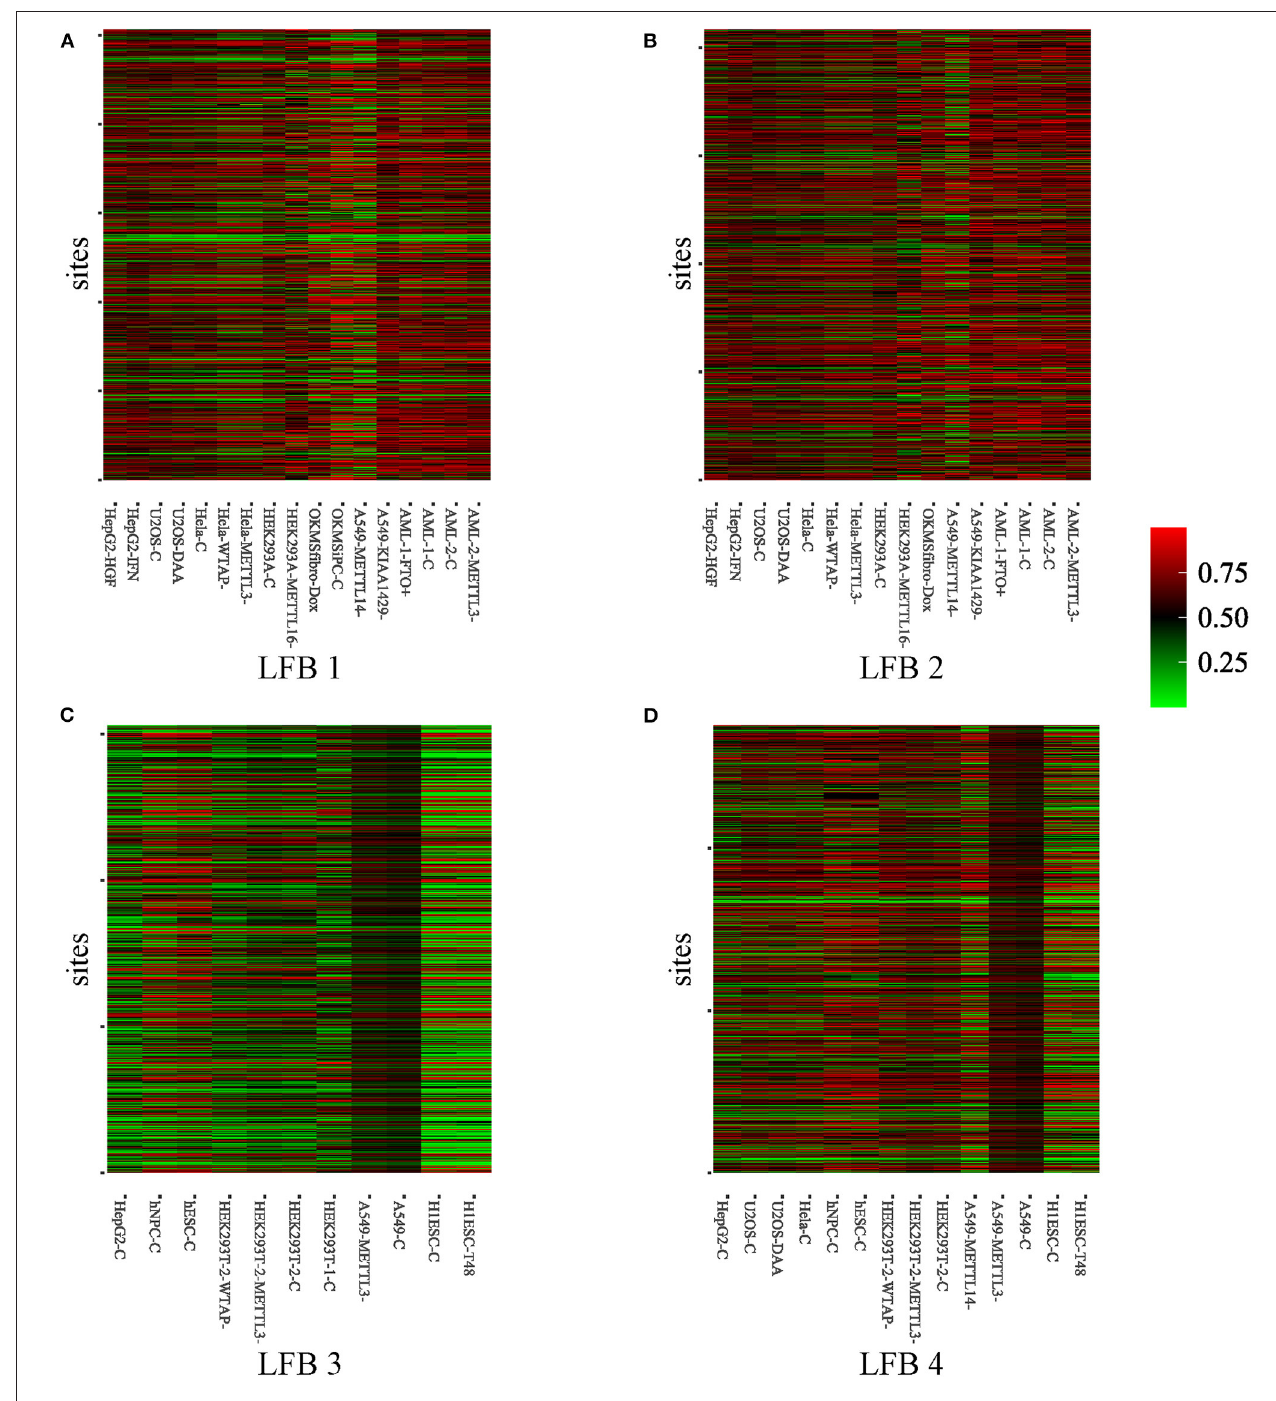
FIGURE 3 | Heatmaps of methylation level of the four selected LFBs. (A) The methylation level heatmap of the LFB1. (B) The methylation level heatmap of the LFB2. (C) The methylation level heatmap of the LFB3. (D) The methylation level heatmap of the LFB4.